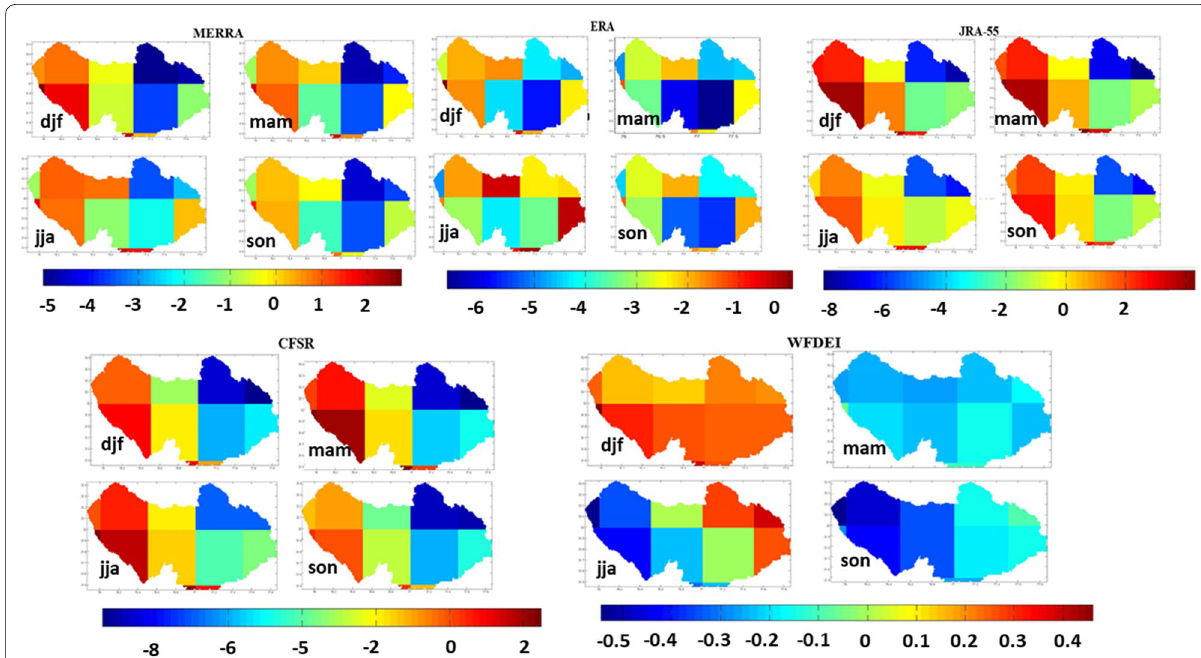
Fig. 11 The mean seasonal temperature bias (°C) between modeled (reanalysis and global meteorological) and CRU observed gridded data for time period 1990–2009 for the Beas river basin. djf (December-February), mam (March–May), jja (June–August) and son